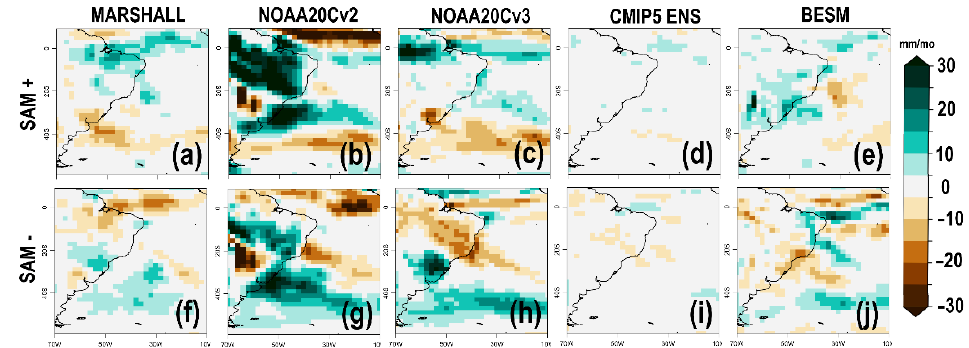
Figure 5. Precipitation anomalies composites according to SAM phases. ( a – e ), positive SAM; ( f – j ), negative SAM. Composites were obtained by averaging precipitation anomalies in months with SAM standardized index values higher than |2|. Precipitation values are in millimeters per month (mm/month). Datasets: ( a , f ), Marshall SAM index and GPCP; ( b , g ), NOAA-20Cv2; ( c , h ), NOAA-20Cv3; ( d , i ), CMIP5 ensemble mean; ( f , j ), BESM. Reference period: 1979–2005.